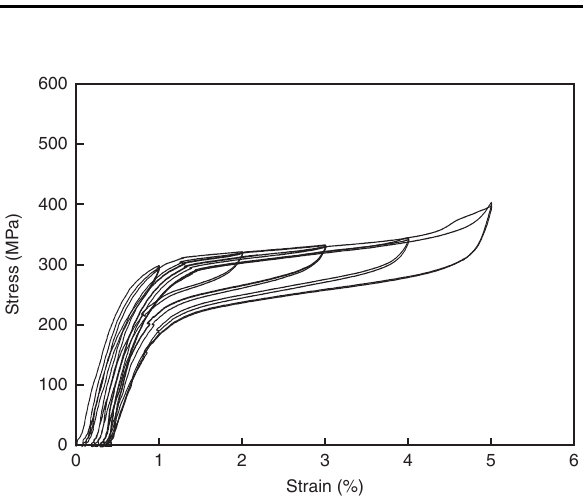
Fig. 6 Tensile superelastic test in Cu-Al-Mn single crystal bar 15.4mm in diameter and 682mm in length. The target strain was incrementally increased up to 5%. Excellent superelasticity was obtained in the long single crystal bar